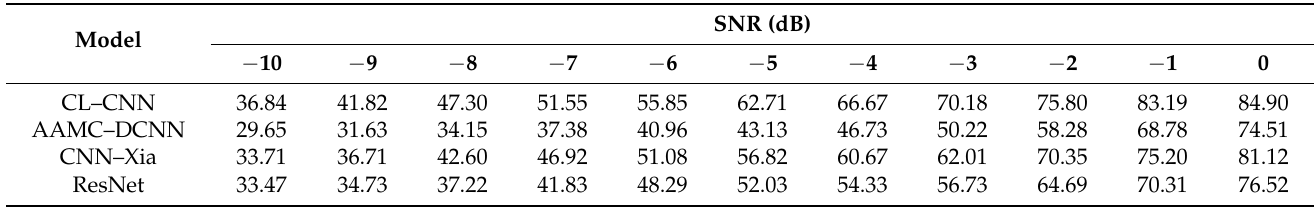
Table 12. Generalization ability test with the sample size for each class being 15.